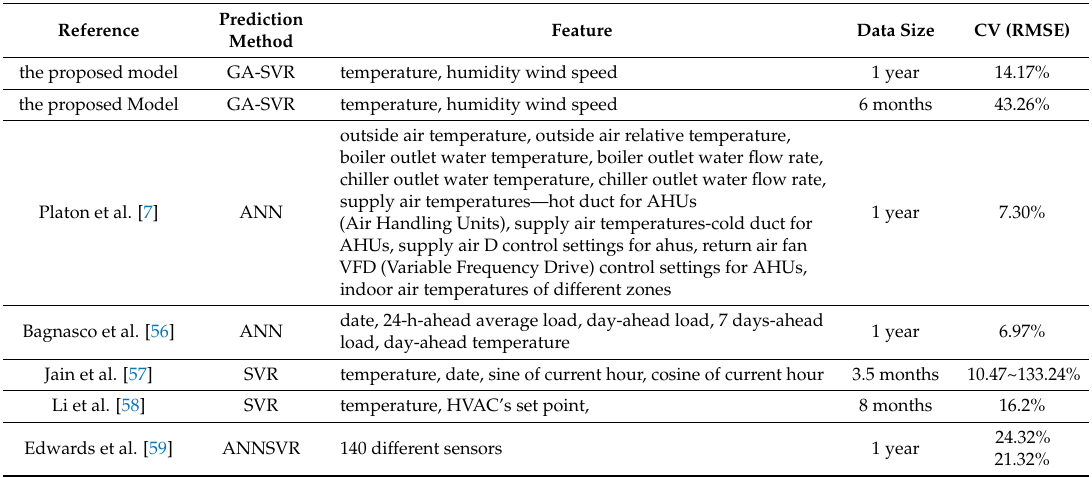
Table 4. Comparison between the proposed model and other